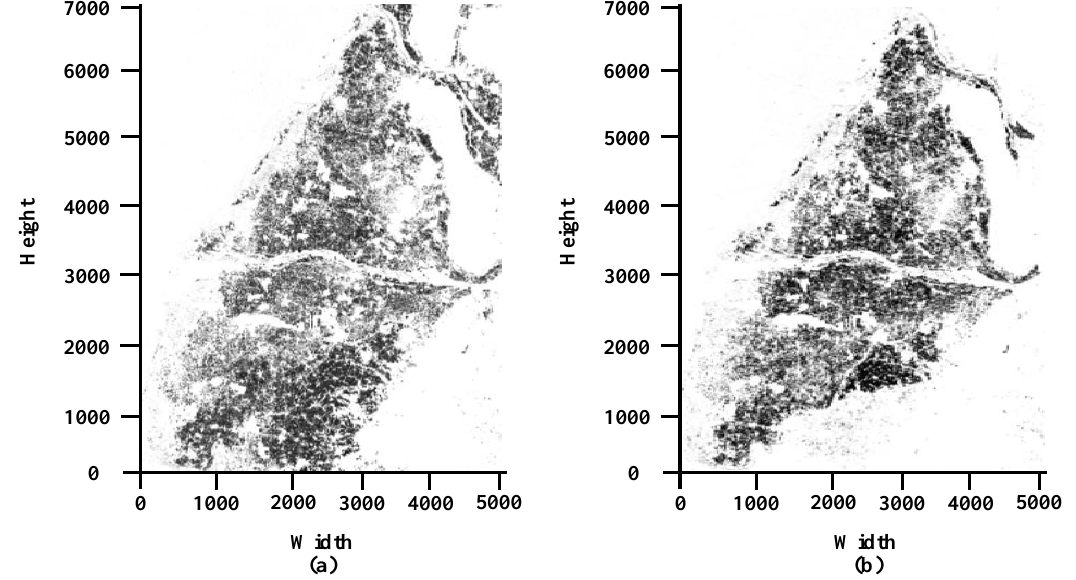
Figure 2. ( a ) The ground truth data of study areas from the Agriculture and Food Agency (AFA). ( b ) The ground truth data of study areas from the Taiwan Agriculture Research Institute (TARI). White indicates the non-rice and black indicates the rice fields, where the height and width represent the number of